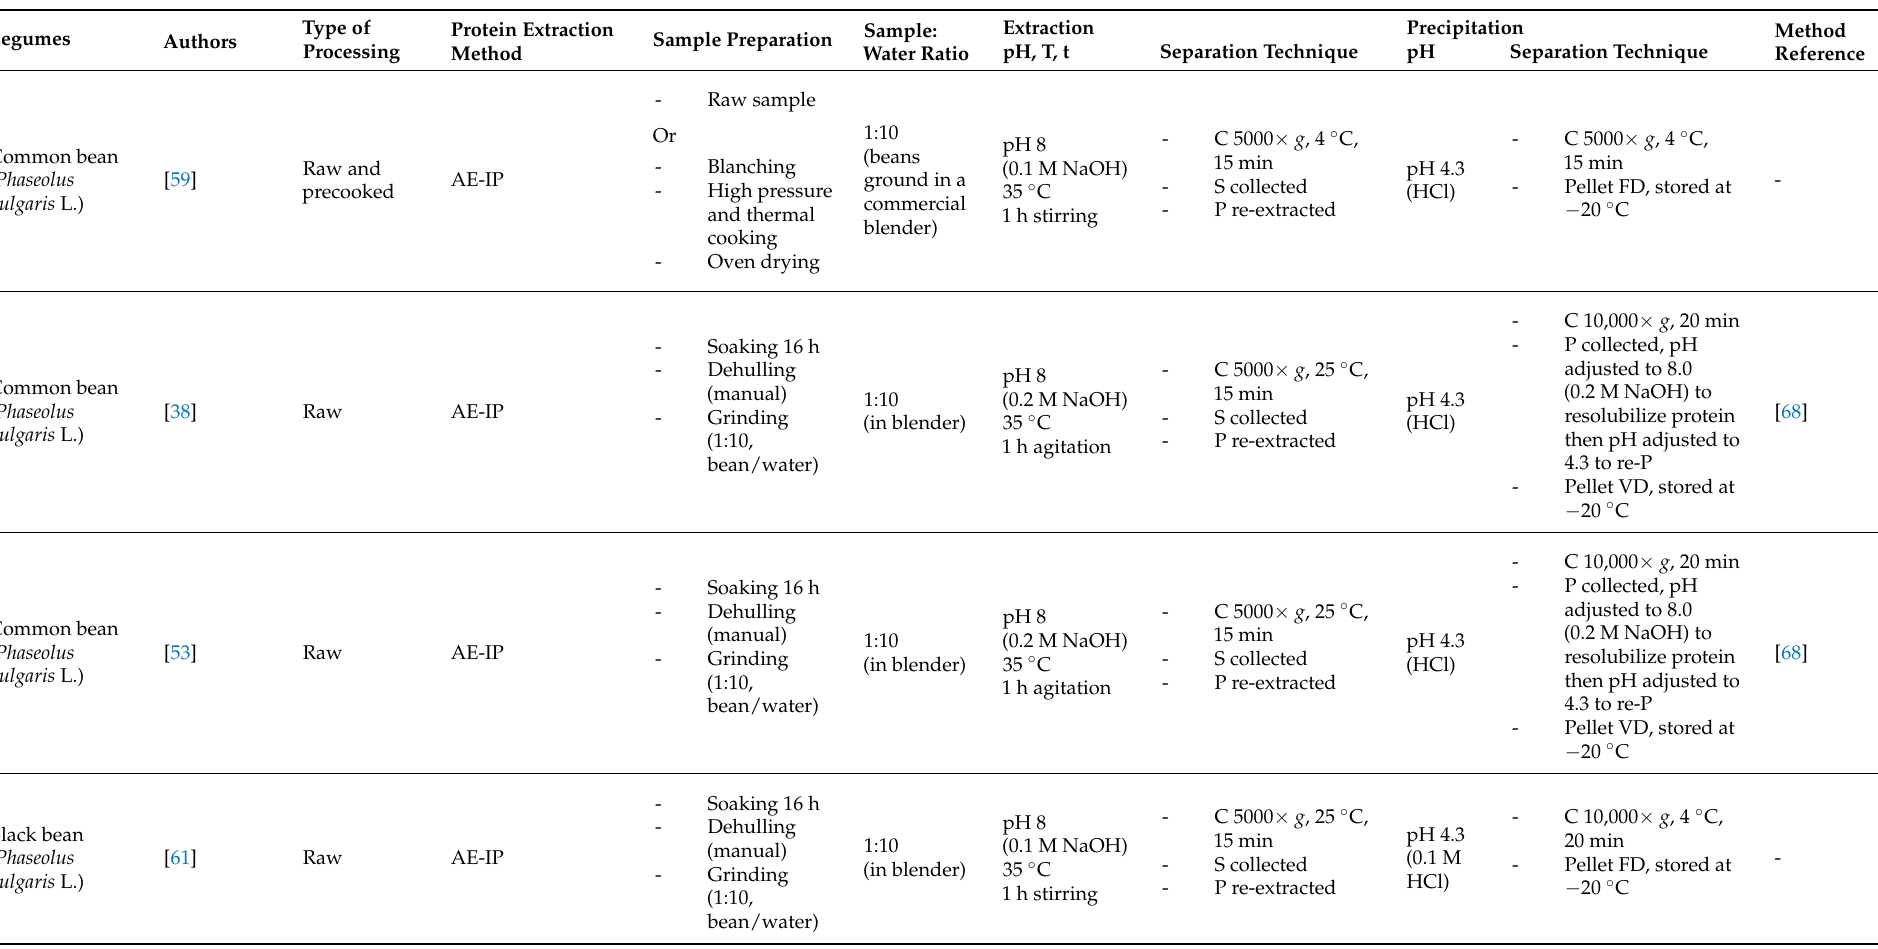
Table 2. Protein extraction